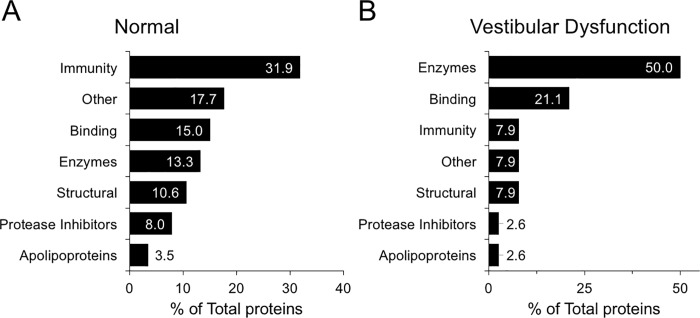
Major protein categories in human perilymph.(A) The perilymph of patients with intact hearing. Within each category, the percentage of the total amount of proteins is denoted within each bar. The Other category included proteins involved in ubiquitination, blood coagulation cascade, and receptors. (B) Categorization of differentially expressed proteins between perilymph fluid from patients with normal hearing and those with vestibular dysfunction.